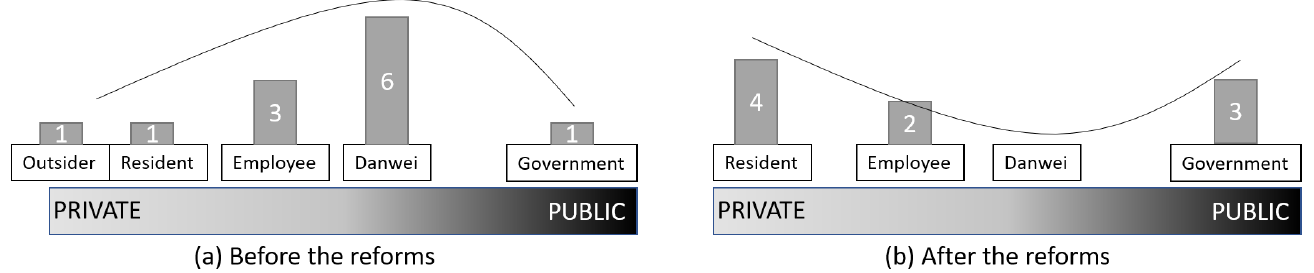
Figure 14. The public-private spectrum of management